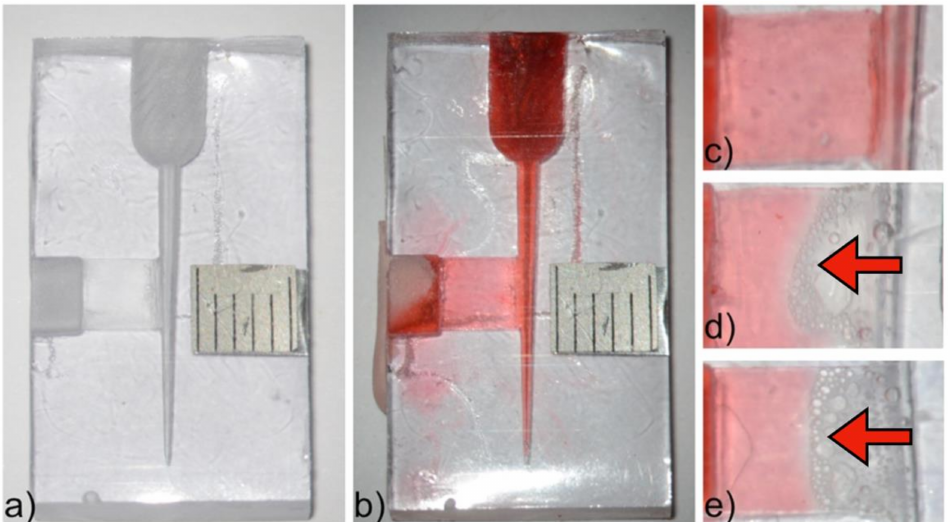
Figure 1. ( a ) A finger spreader and a matrix band were used to create models representing a root canal with a lateral isthmus. ( b ) The model was filled with gelatin mixed with red food dye. ( c ) Irrigation with physiological saline was used as a negative control. ( d ) When NaOCl was used as an irrigant and activated with am ultrasonically oscillating tip for 30 s, 43.2 ± 8.7% of isthmus surface was cleaned. ( e ) Adding HEDP to NaOCl did not affect cleaning efficacy (47.9 ± 9.4% cleaned, p > 0.05), as can be appreciated by comparing panels ( d ) and ( e )